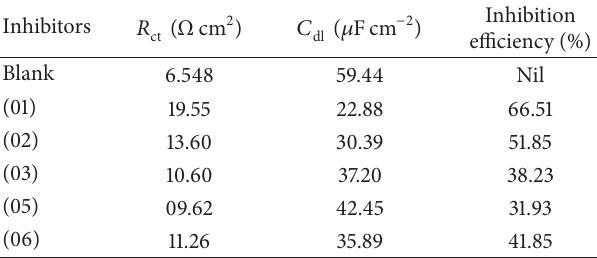
Table 6: Impedence parameters for mild steel in 1N H absence and presence of optimum concentration (0.4 × 10 − 3 M) of variously substituted piperidin-4-ones.